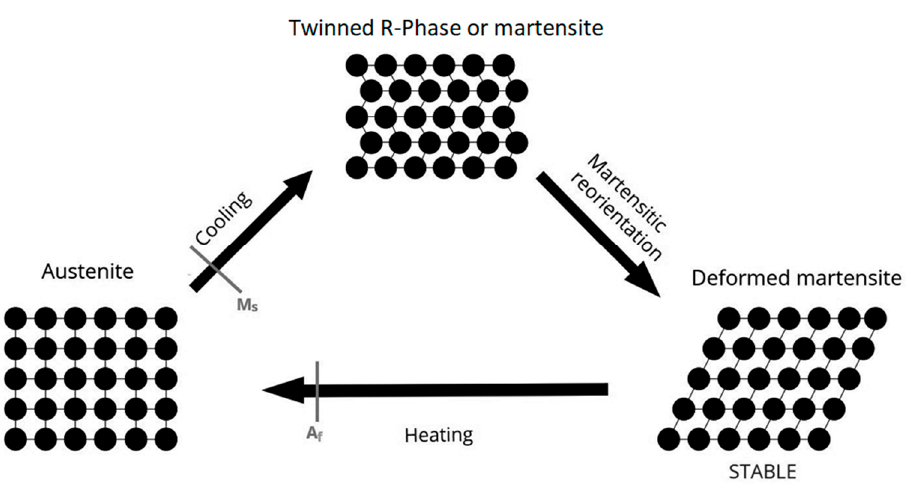
Figure 2. Demonstration of shape memory effect (SME). Austenite (above the austenite finish temperature, A f ) is cooled to a twinned martensitic phase (from the martensitic start temperature, M s ) known as R-phase. As NiTi in the R-phase cannot be ground, it is instead twisted and reoriented into a stable martensitic phase and is heated and cooled back into the austenite crystalline structure [6].